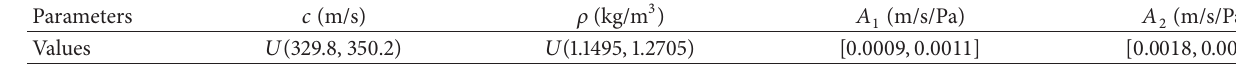
Table 1: Characteristics of the uncertain parameters of the 2D rectangular cavity.